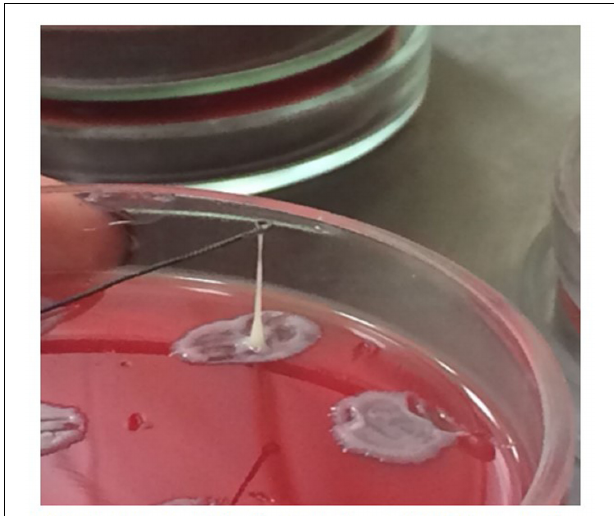
FIGURE 1 | Hypermucoviscosity phenotype of Klebsiella pneumoniae. When the colonies were touched with a loop and the loop lifted vertically from the surface of the blood agar plate, the mucoid isolates adhered to the